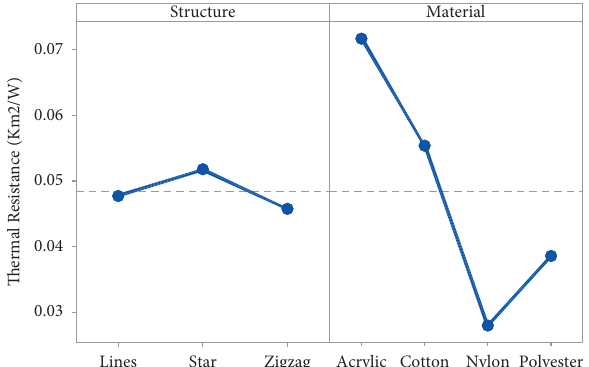
Figure 23: Main efect plot of thermal resistance.